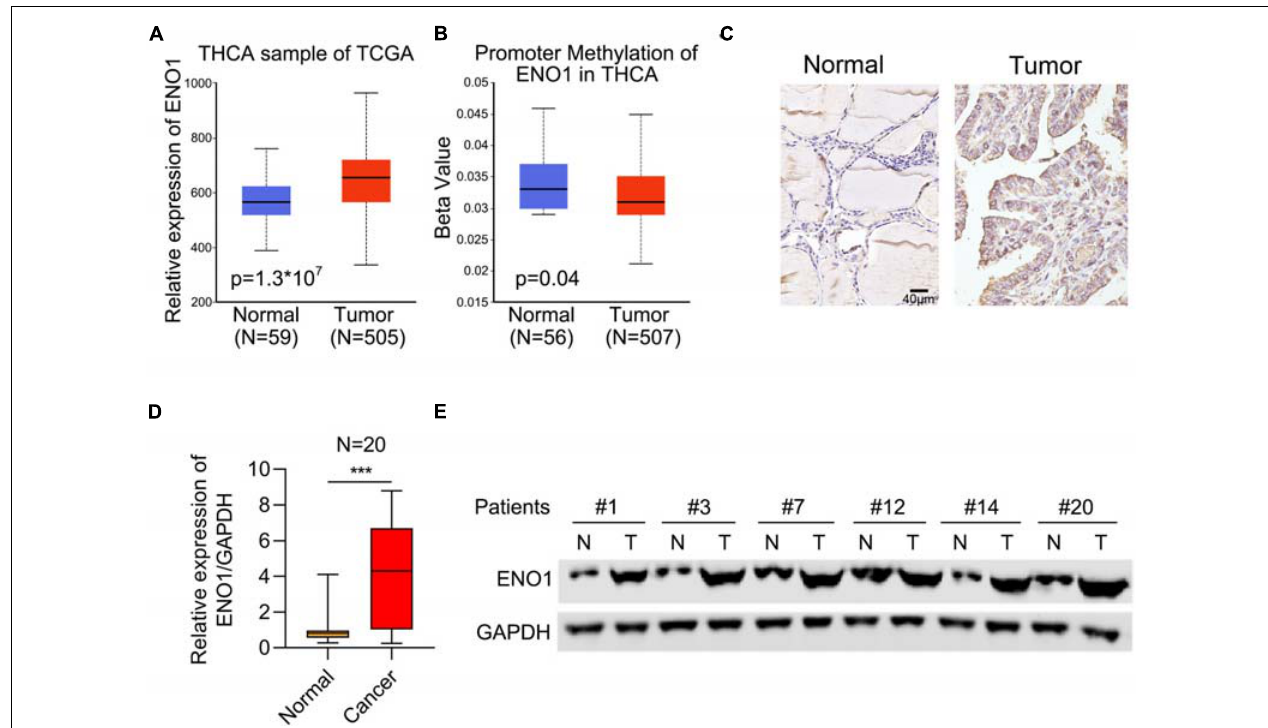
FIGURE 1 | Upregulation of ENO1 in thyroid carcinoma. (A) Analysis of ENO1 expression in thyroid carcinoma ( n = 505) and normal samples ( n = 59) from THCA. (B) Analysis of promoter methylation of ENO1 in thyroid carcinoma ( n = 507) and normal samples ( n = 56) from THCA. (C) IHC analysis of ENO1 expression in normal and thyroid carcinoma tissues. (D) qRT-PCR analysis of ENO1 expression in normal and thyroid carcinoma tissues. (E) Western blotting analysis of ENO1 expression in normal and thyroid carcinoma tissues. GAPDH serves as a loading control. *** p <